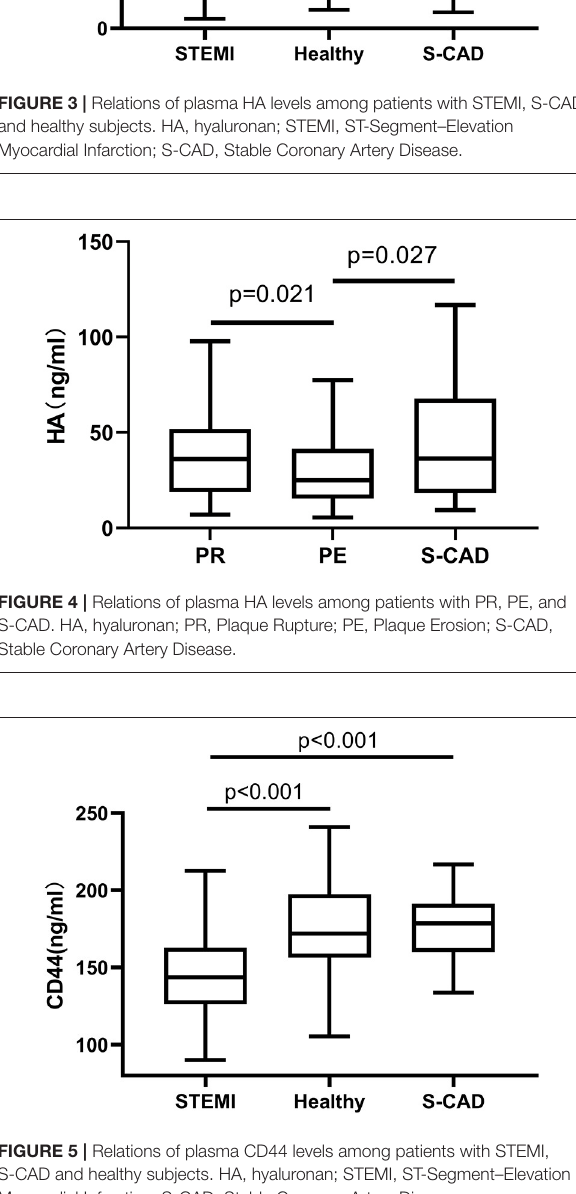
According to the ROC analysis, the AUC of HA levels in discriminating plaque erosion from rupture was 0.605 (95% CI 0.518–0.692, p = 0.021) ( Figure 6 ). The optimal